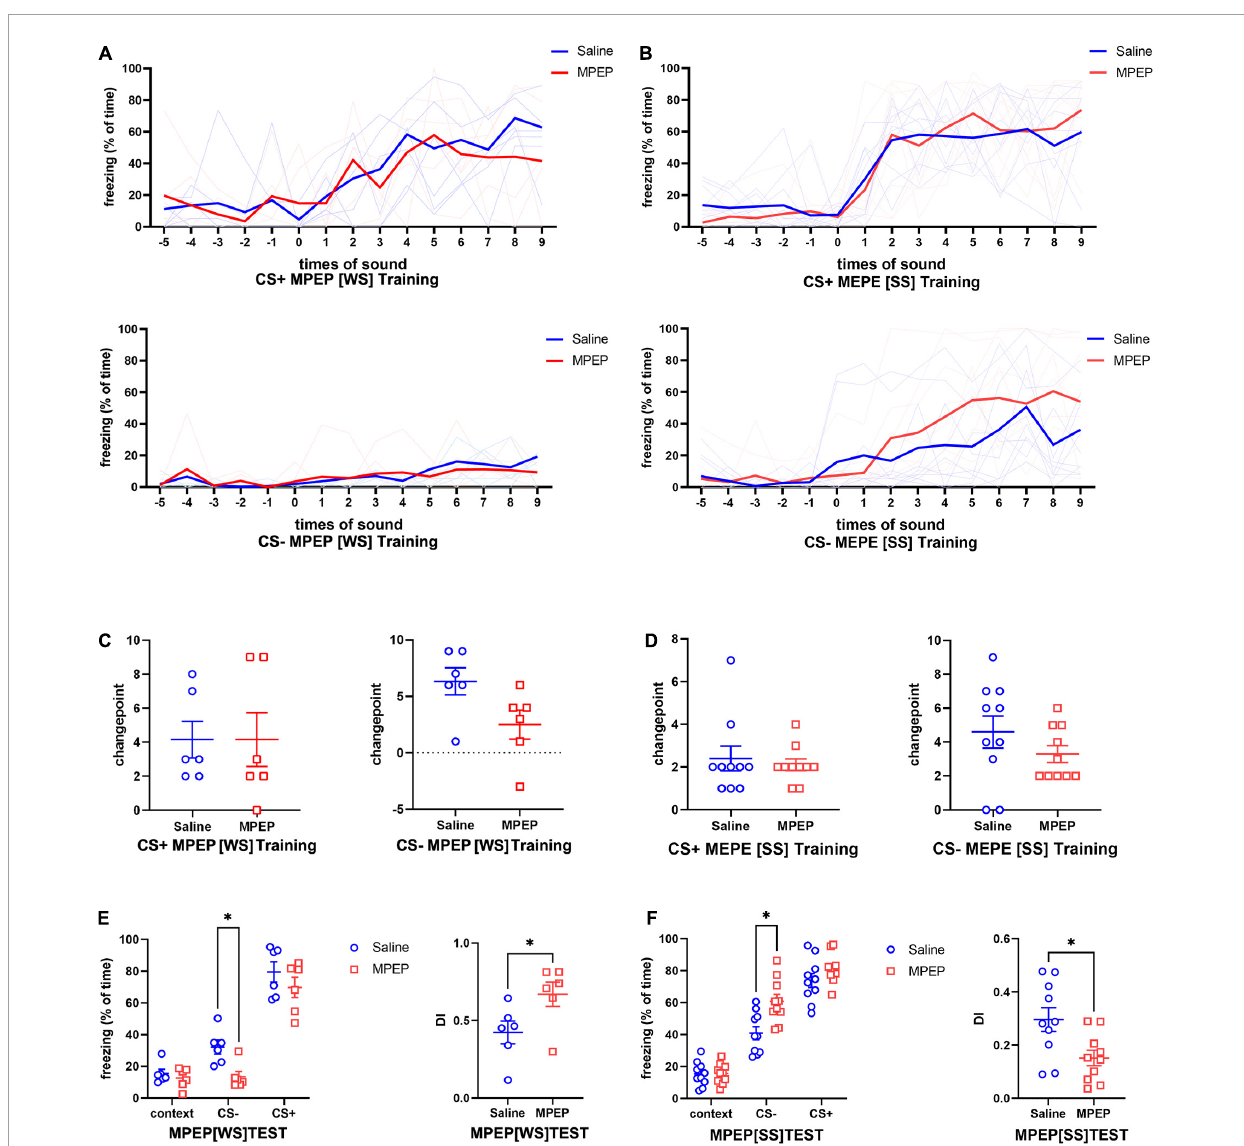
FIGURE6 Inhibition of mGluR5 during fear conditioning leaded to a stress intensity dependent alteration on fear memory generalization. (A,B) Significant differences were not found in fear response to CS+ or CS- between control group and MPEP group regardless of the given foot shock intensity (A) , two-way ANOVA CS+[WS] F 1 , 10 = 0.0004339, p = 0.9838; CS-[WS] F 1 , 10 = 1.050, p = 0.3297; (B) two-way ANOVA CS+[SS] F 1 , 18 = 0.01473, p = 0. 9047; CS-[SS] F 1 , 18 = 1.273, p = 0.2741). (C) Changepoints on freezing to CS+ or CS- were not altered by MPEP treatment during WS CFC training (CS+[WS], unpaired two-tailed Student t -test, Two-tailed, t = 0.000, df = 10, p > 0.9999; CS-[WS], unpaired two-tailed Student t -test, Two-tailed, t = 2.157, df = 9, p = 0.0594). (D) The changepoints to CS- rather than CS+ in the MPEP group were significant lower than the saline group during SS CFC training (CS+[SS], unpaired two-tailed Student t -test, Two-tailed, t = 0.4660 , df = 18, p = 0.6468; CS-[SS], unpaired two-tailed Student t -test, Two-tailed, t = 1.218, df = 18 p = 0.2389). (E) MPEP leaded to decreased fear response to CS- and increased DI during test when using WS